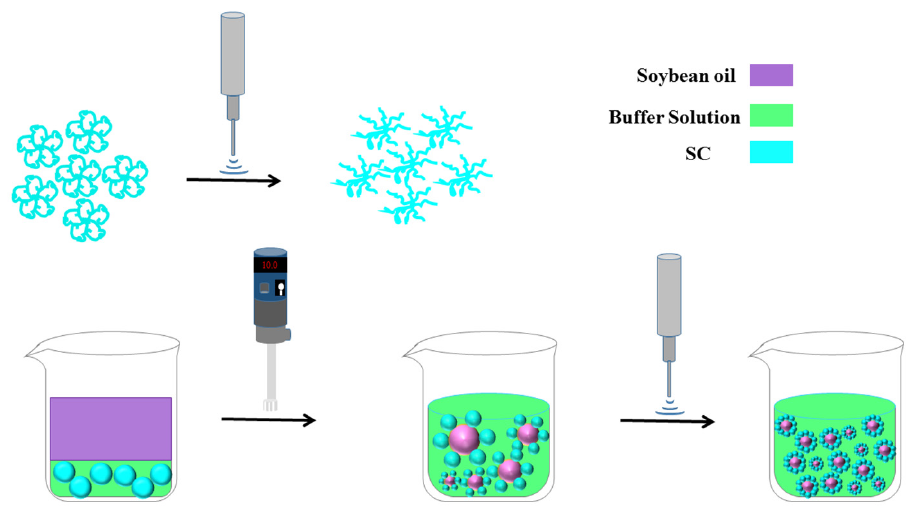
Figure 9. Proposed mechanism of the relation between the stability of SC-coated O/W emulsions and the physicochemical and structural characteristics of SC by a high-intensity ultrasound. Emulsified meat products, such as sausages, meatballs and burgers, are the most popular ready-to-eat foods for consumers. In general, emulsified meat products have a high level of fat, ranging from 20% to 30%. Excessive consumption threatens human health and easily leads to obesity and certain chronic diseases. The better method to replace animal fat in emulsified meat products is the application of pre-emulsification, that is, using non-meat proteins instead of animal proteins to wrap fat globular, and then using pre-emulsified vegetable oil instead of pig back-fat. However, the pre-emulsion prepared in the actual production process is unstable and needs to be processed into the minced meat system in time. The ultrasound treatment enhanced the SC-coated O/W emulsions stability, which could be applied in the industrial processing of emulsified meat products. 4. Conclusions The results revealed that ultrasound treatment might destroy the tertiary structure but leave most of the integral secondary structure by reducing particle size, increasing surface hydrophobicity and fluorescence intensity, exposing tyrosine and tryptophan to the protein surface and forming small aggregates and a loose structure of SC. The physi- cochemical and structural changes were closely related to the enhanced SC adsorption to oil droplets and emulsions stability. SC stabled O/W emulsions by the ultrasounds exhib- ited excellent stability under environmental stresses. The oil droplets of treated emulsions after storage and the thermal and freeze–thawing process were still uniform and stable, especially for 6 min and 9 min. The stabilization mechanism for ultrasound-induced emul- sion prepared by SC as an emulsifier needs further study. The high-intensity ultrasounds have the potential to enhance the stability of protein-prepared O/W emulsions and are of great significance in practical emulsified products. Author Contributions: Conceptualization, X.H. and K.L.; methodology, X.H. and K.L.; validation, X.H., S.J., Y.L., Y.Z. and H.Z.; formal analysis, X.H., Y.Z., H.Z. and K.L.; investigation, X.H., S.J., J.W. and Y.L.; data curation, K.L.; writing—original draft preparation, X.H., S.J., J.W., Y.L., Y.Z., H.Z. and K.L.; writing—review and editing, X.H., S.J., Y.L., Y.Z., H.Z. and K.L.; supervision, K.L.; funding acquisition, K.L. All authors have read and agreed to the published version of the manuscript.